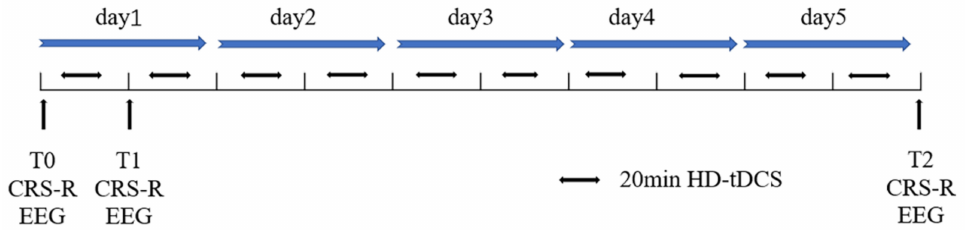
Figure 1. Stimulation Protocol. T0, time before HD-tDCS; T1, after a single session of HD-tDCS; T2, after 10 sessions of HD-tDCS for 5 days. All DOCs patients received HD-tDCS 10 times (2